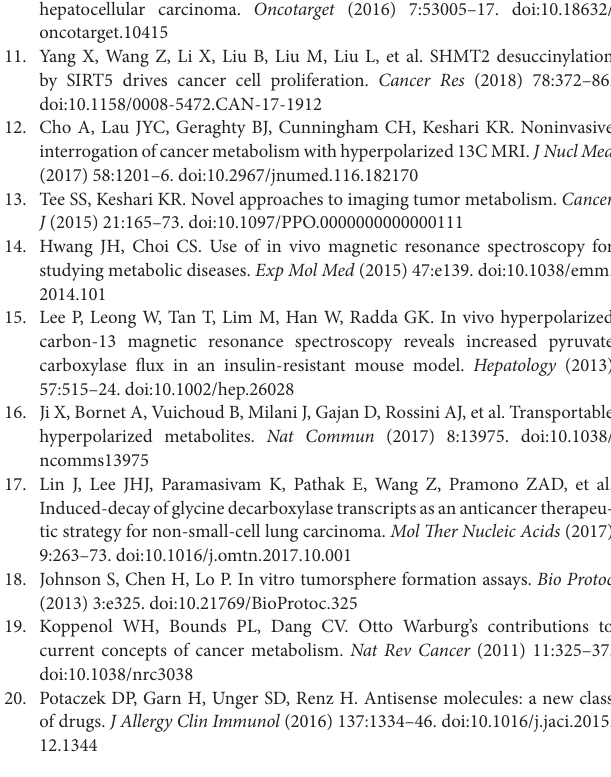
FigUre s1 | MTT assay to show the effect of glycine decarboxylase-steric hindrance antisense oligonucleotide (shAON) on cell proliferation in several cancer cell lines. 2,000 cells were seeded into 96-well microplate for overnight followed by shAON transfection for 3 days. The data represent mean ± SEM of three independent